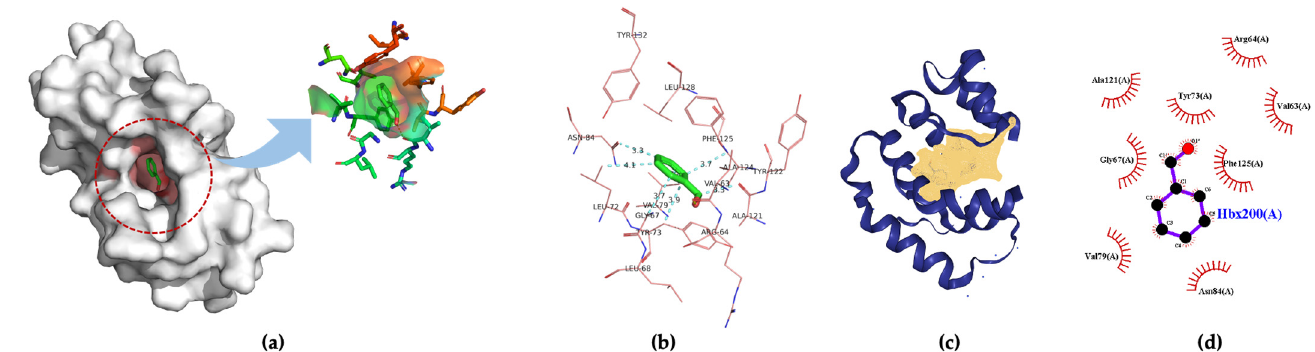
Figure 4. ( a ) 3D visualization of the docking model; ( b ) binding residues identification; ( c ) best position of predicted binding pocket; ( d ) 2D ligand–protein interaction diagrams of AgamOBP22a (PDB ID:3L4L) with benzaldehyde.